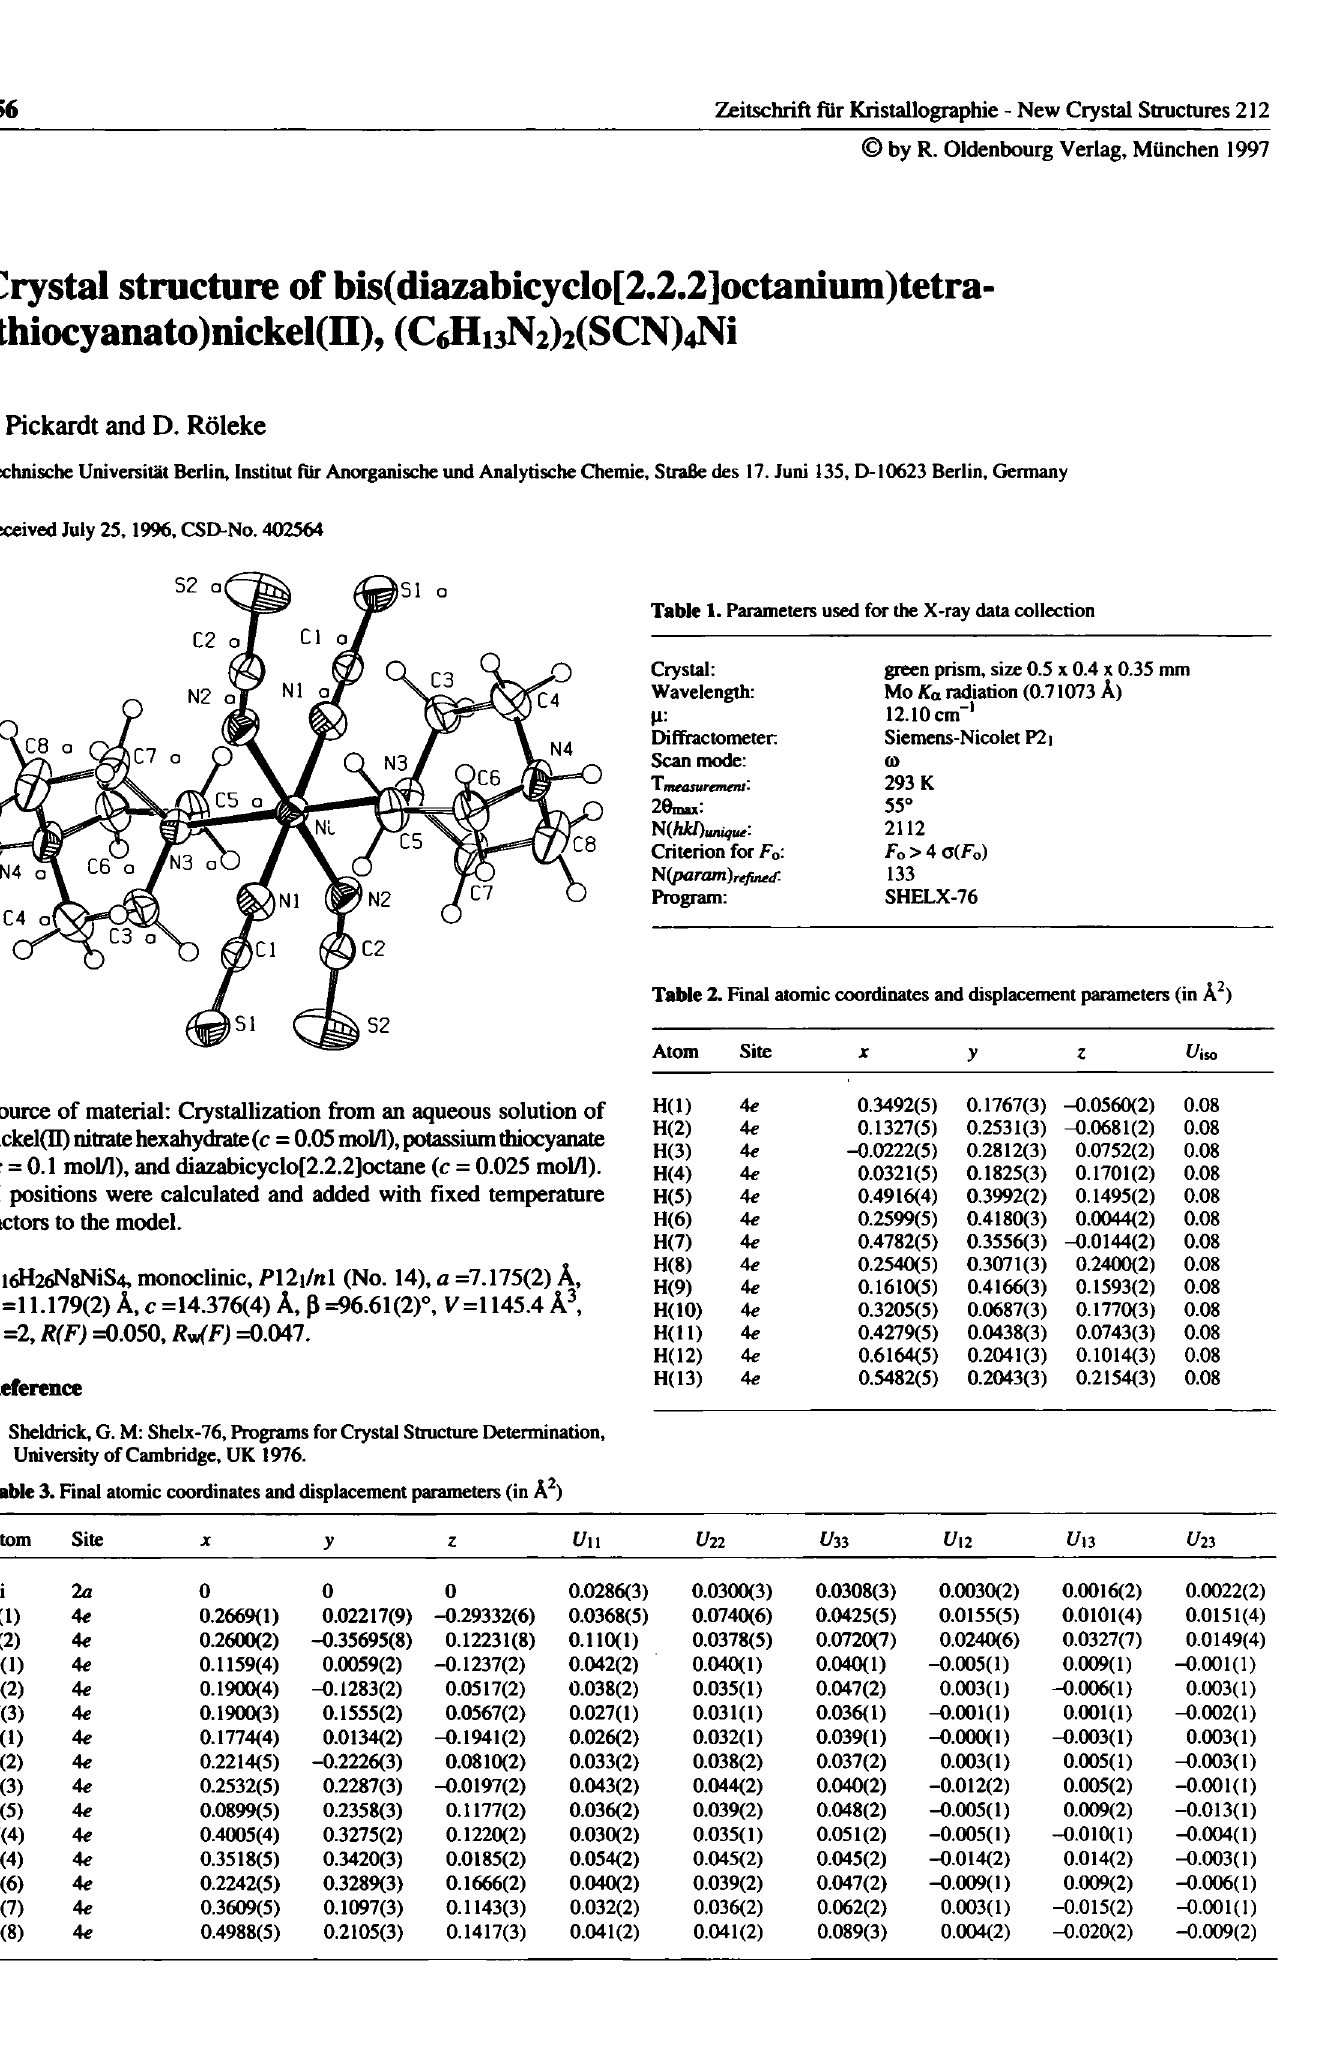
Table 3. Final atomic coordinates and displacement parameters (in A 2 )